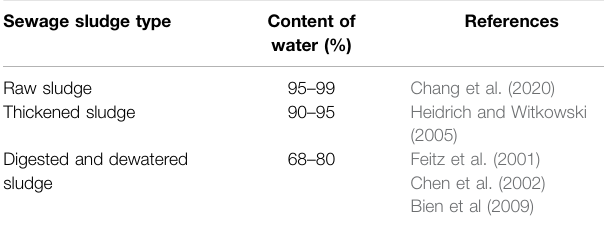
TABLE 1 | ontent of water in sewage sludge at different treatment stages according to different authors. Sewage sludge type Content of water (%)